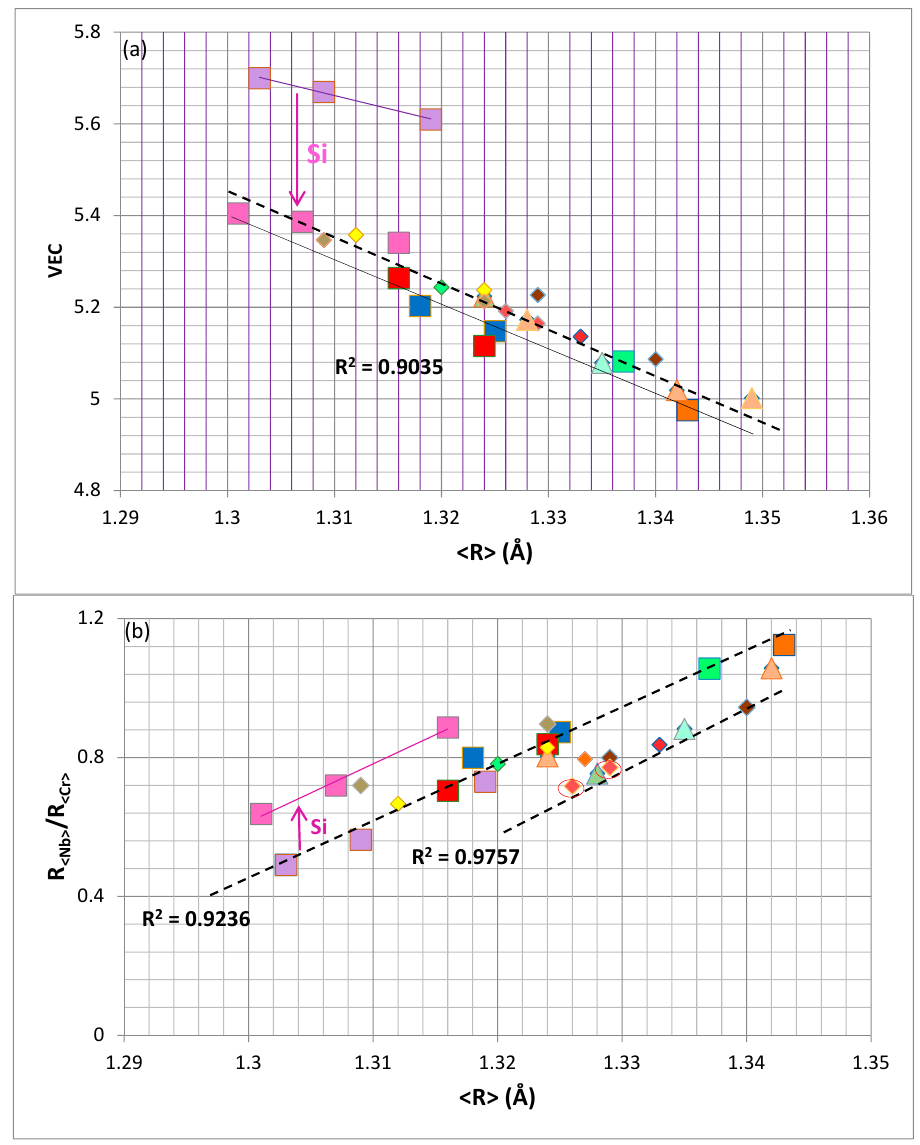
Figure 3. Laves phase maps ( a ) VEC versus <R> = R <Nb> + R <Cr> and ( b ) R <Nb> /R <Cr> versus <R> = R <Nb> + R <Cr> . Lavender, pink, blue, red, green and dark orange squares represent the same data as in Figure 2a. The triangles represent data for (Nb,Ti)(Cr,Si,Al,Sn) 2 and (Nb,Ti,Mo,Hf)(Cr,Si,Al,Sn) 2 (light orange), and (Nb,Ti)(Cr,Si,Al,Ge) 2 (light green); diamonds represent data for (Nb,Mo)(Cr,Si,Al) 2 (yellow), (Nb,Ti,Ta)(Cr,Si,Al) 2 , (Nb,Ti,Hf)(Cr,Si,Al) 2 , (Nb,Ti,Mo,Hf)(Cr,Si,Al) 2 (red), (Nb,Ti,Hf)(Cr,Si,Ge) 2 (light green), (Nb,Hf)(Cr,Si,Sn) 2 and (Nb,Ti,Hf)(Cr,Si,Sn) 2 (dark orange), (Nb,Ti,Mo,W,Hf)(Cr,Si,Sn) 2